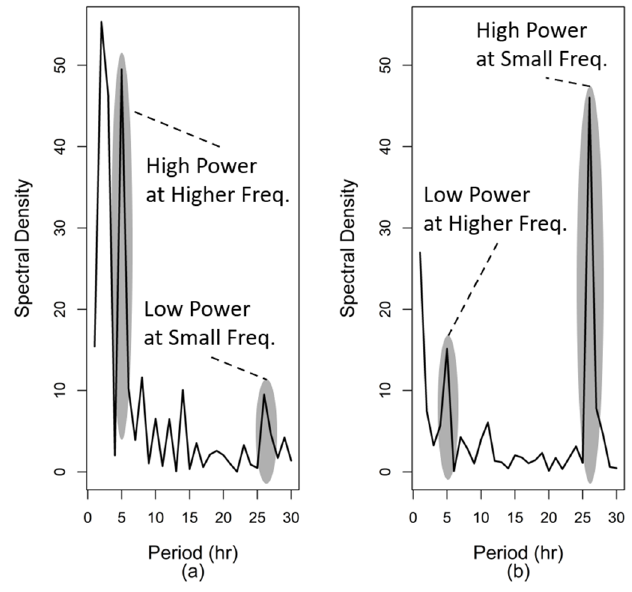
Figure 2. Power spectrum for the indoor temperature measured at the thermostat for ( a ) high- and ( b ) low-efficiency houses.